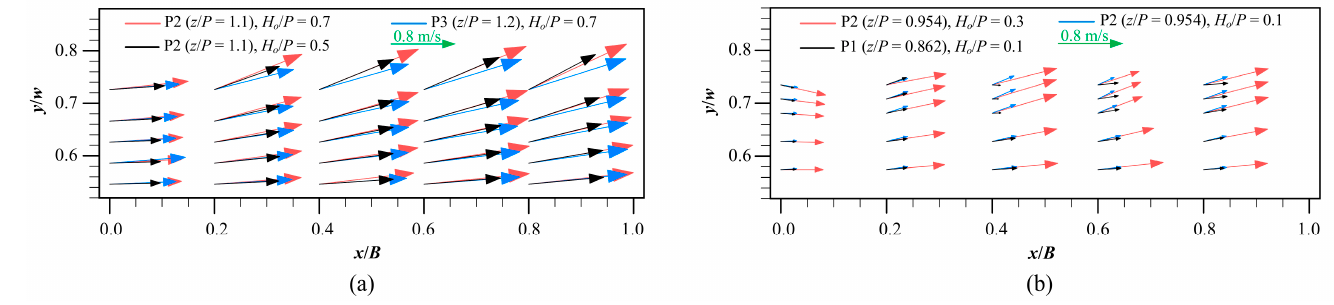
Figure 11. Velocity vectors in ( a ) Rec-B2 model; ( b ) base model.